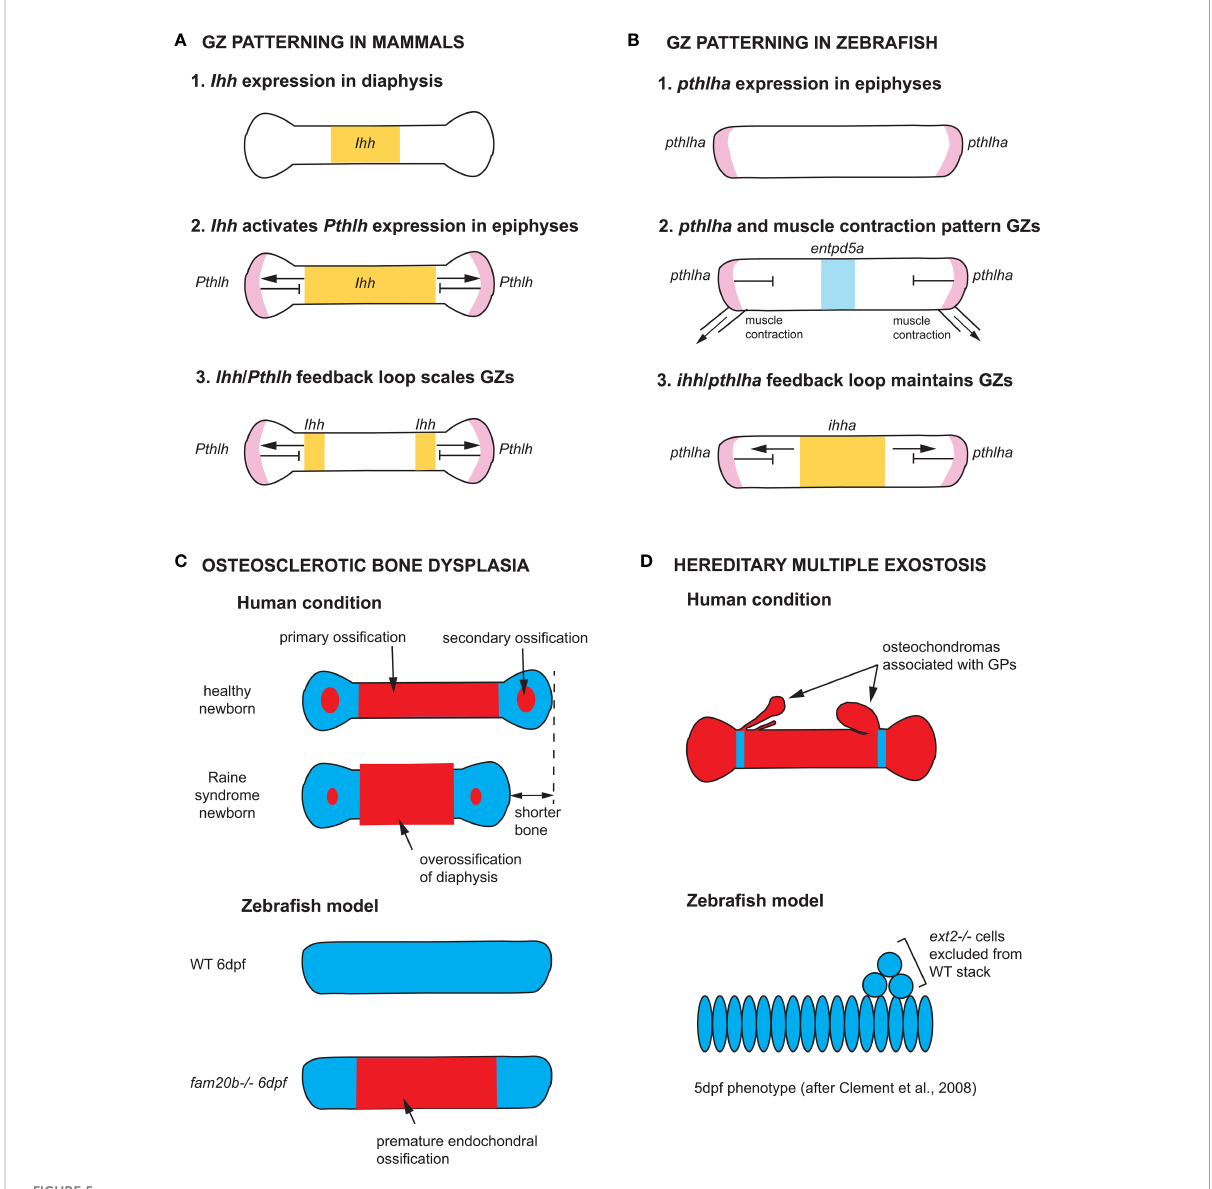
FIGURE 5 Zebra fi sh models of endochondral growth zone development and disease (A) Model for the patterning of growth zones (GZs) based on genetic studies of mouse long bones (82 – 84). Indian hedgehog (Ihh) is fi rst expressed in the nascent diaphysis of the cartilage model. Its expression domain expands towards the epiphyses and activates Parathyroid hormone-like hormone ( Pthlh ) expression in periarticular cartilage. Pthlh represses Ihh at a distance, which sets the distance between the hypertrophic zone (HZ) and resting zone (RZ). (B) Model for the patterning of CH GZs in zebra fi sh based on (46). pthlha is expressed at the epiphyses of the differentiating CH. The HZ is then patterned by pthlha and muscle contractions before the onset of ihha expression. According to this model, ihha plays a role in the maintenance of GZs, not their patterning. (C) Zebra fi sh fam20b mutants recapitulates the skeletal phenotype of Raine syndrome, a particular form of osteosclerotic bone dysplasia (45). Short overossi fi ed long bones are observed in Raine syndrome newborns. Premature ossi fi cation of the CH diaphysis is observed in zebra fi sh fam20b mutants. (D) Zebra fi sh chimaeras recapitulate the formation of cartilage nodules observed in the human condition hereditary multiple exostosis, which results from a mutation in the EXT2 gene. ext2-/- chondrocytes are excluded from WT cartilage stacks in zebra fi sh chimaeras, leading to the hypothesis that osteochondromas observed in EXT2+/- patients result from loss-of-heterozygosity (85). Ihh and ihha expression domains in yellow, Pthlh and pthlha expression domains in pink, ectonucleoside triphosphate diphosphohydrolase 5a ( entpd5a ) expression domain in light blue, cartilage in blue, and bone in red. CH, ceratohyal; GPs, growth plates; WT, wild type; dpf, days